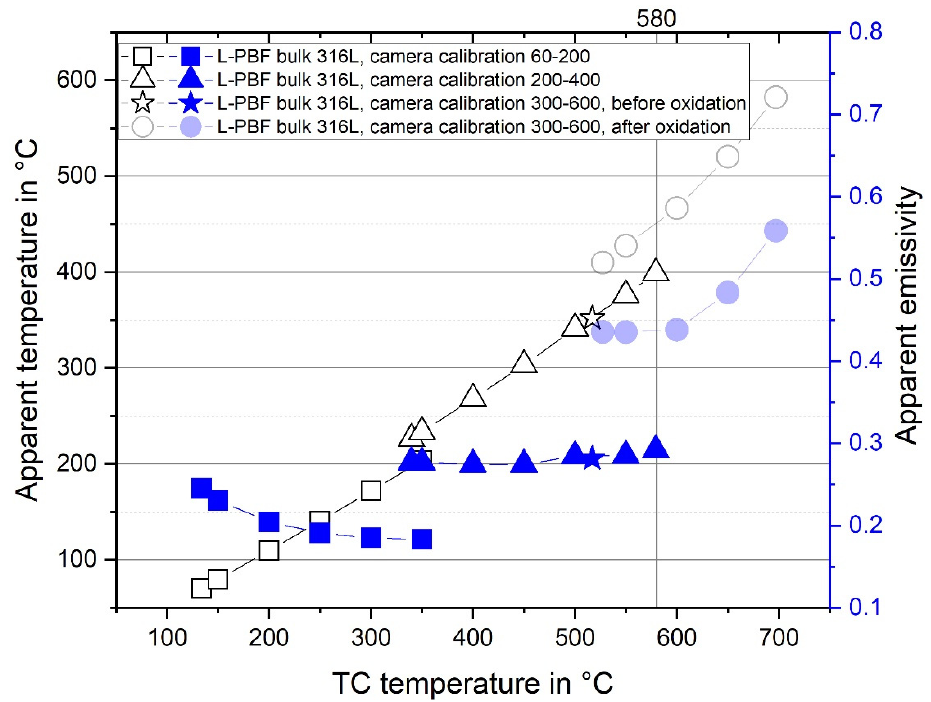
Figure 9. Apparent temperature (black hollow symbols) and apparent emissivity (blue full symbols) of 316L L-PBF bulk surface over measured TC temperature. In the camera calibration range 300–600, measurements were conducted before the onset of increased oxidation (star symbols) and after oxidation (circle symbols).